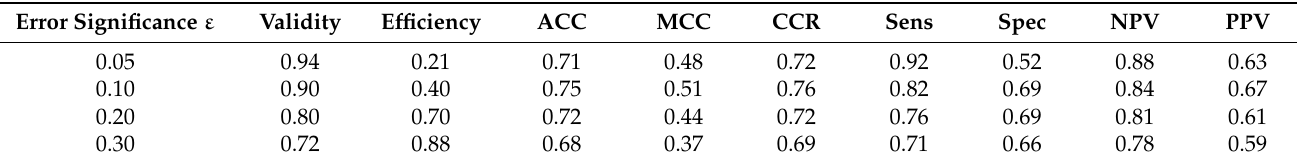
Table 8. Test set performance of the classifier trained exclusively on predicted values of the DPRA, KeratinoSens and h-CLAT